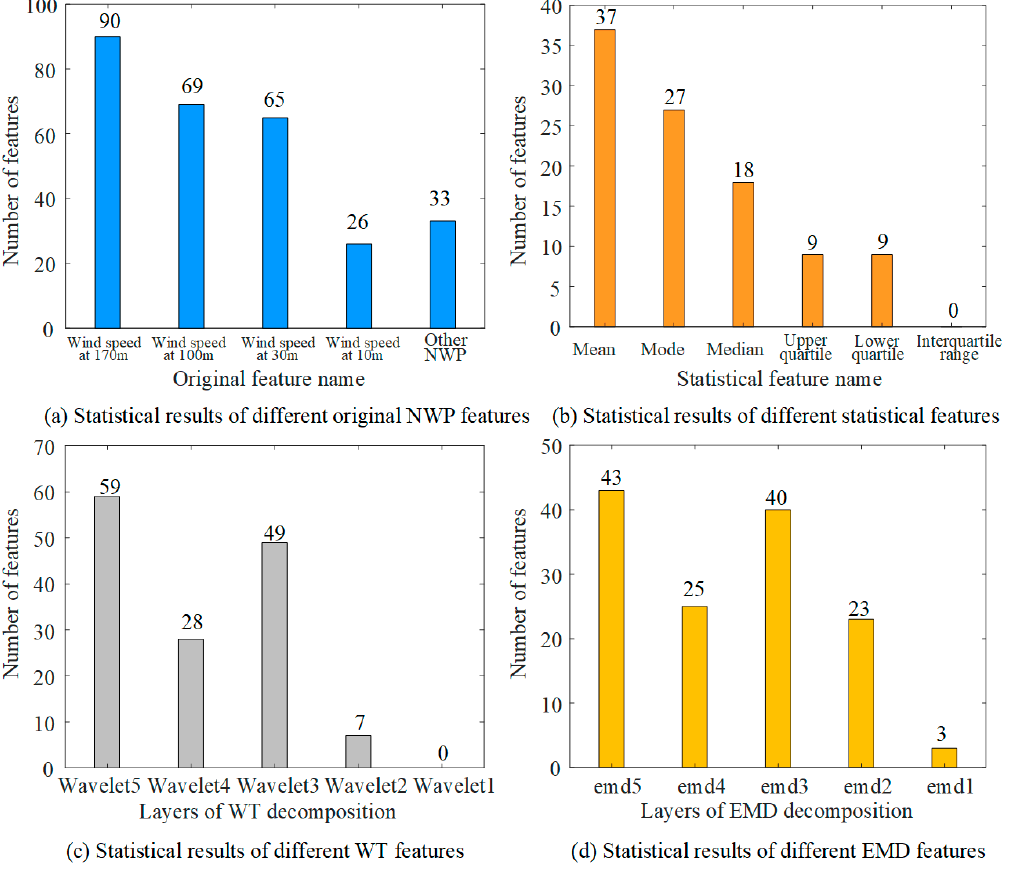
Figure 12. Statistical results of subdivided valid features.